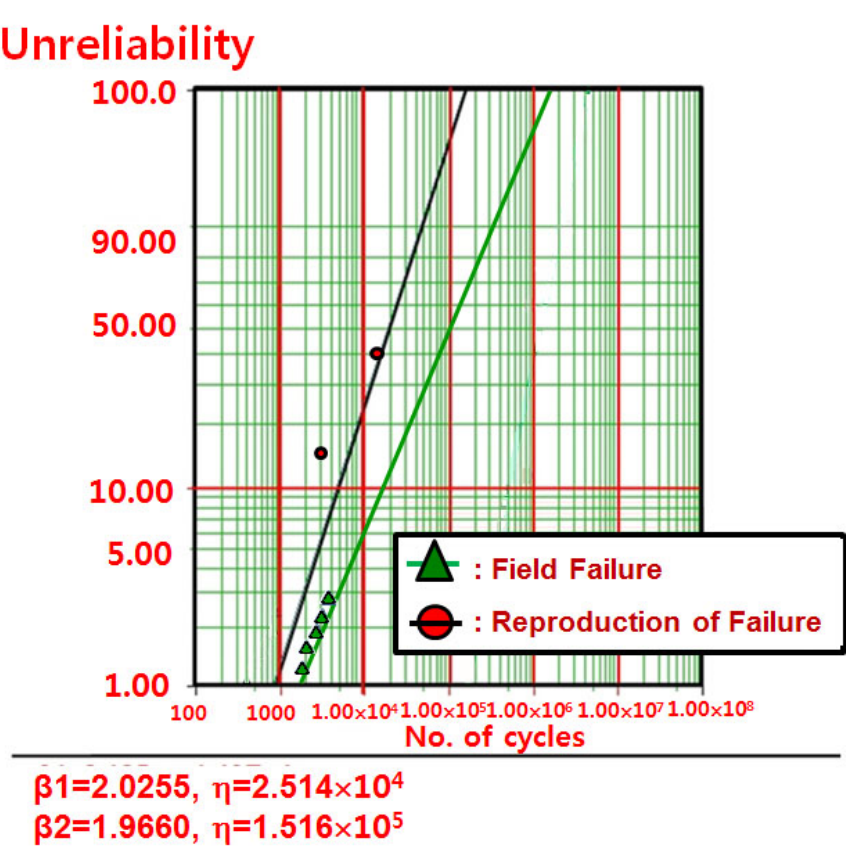
Figure 10. Market data and outcomes of 1st ALT on Weibull plot.